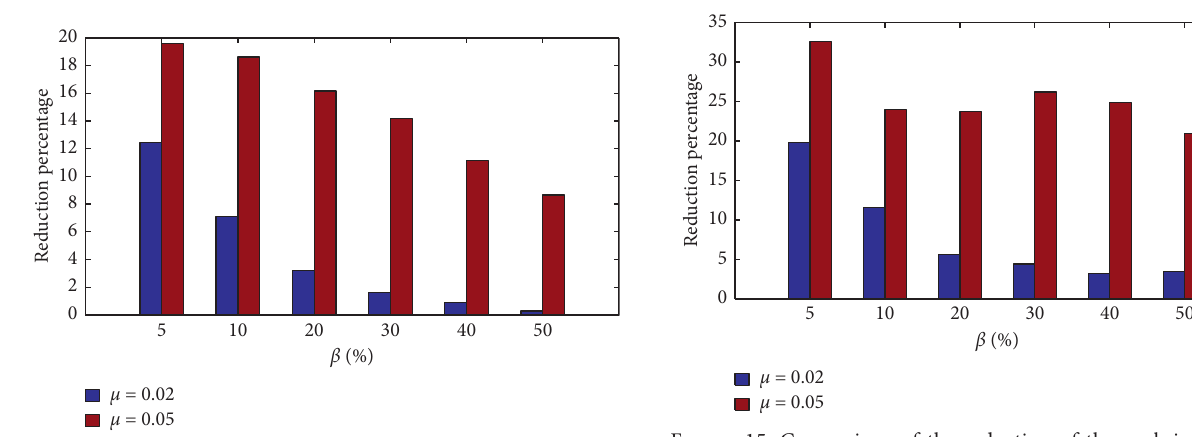
Figure 13: Comparison of the reduction of the 11 th storey peak displacement of the structure subjected to “ Algarrobo ” acceleration record for TMDI designed with µ � 2% and µ � 5% using the J P optimization